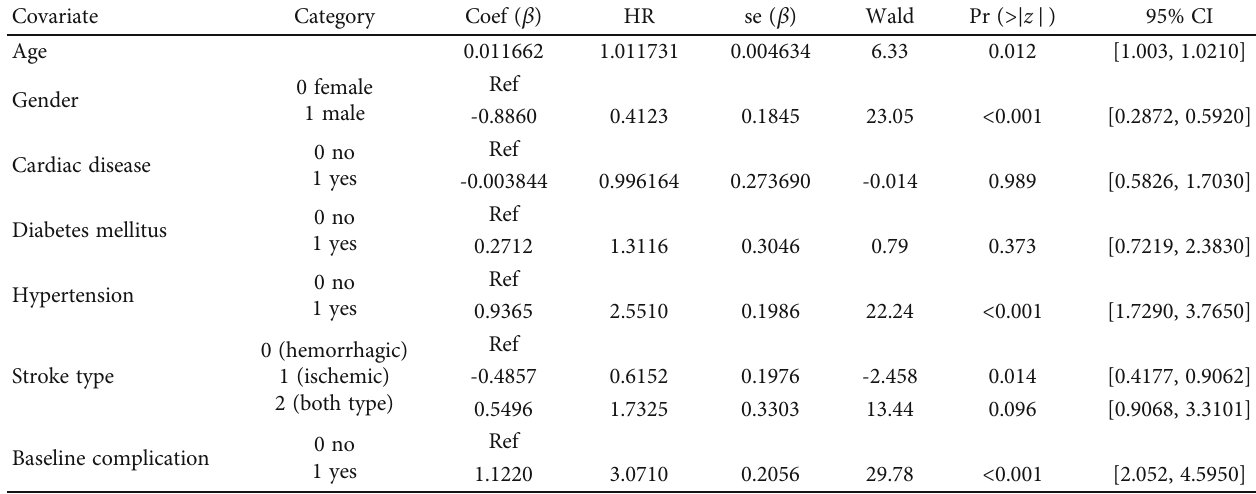
Table 3: Summary univariable (single covariate) Cox PH analysis.